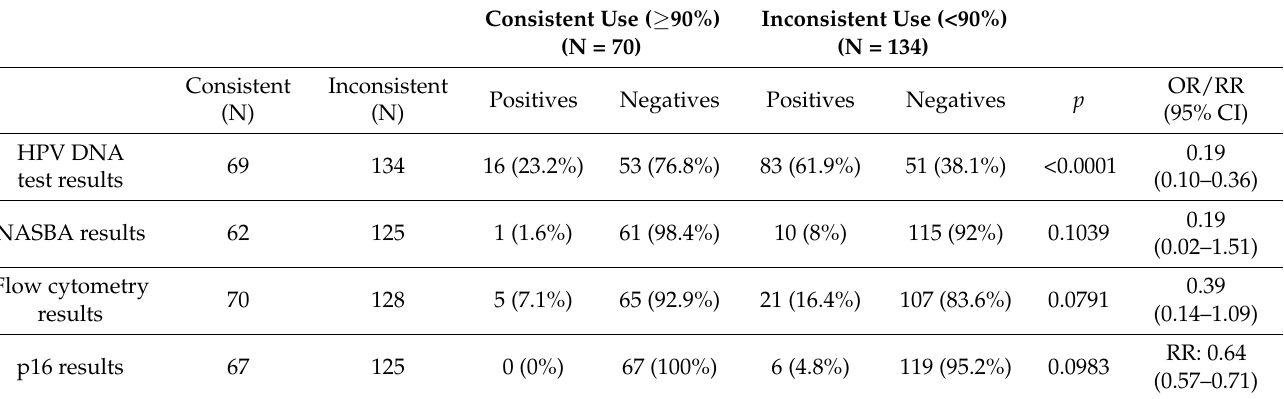
Table 4. Laboratory outcomes for the two groups and statistical comparison at the 6 months follow